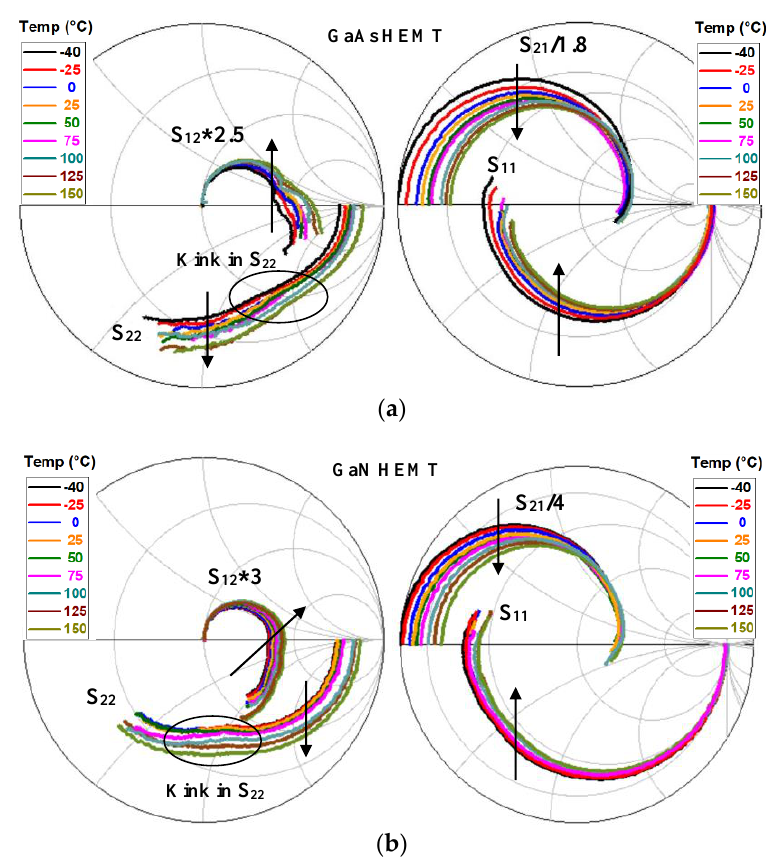
Figure 6. Measured S -parameters of the studied ( a ) GaAs and ( b ) GaN HEMTs at different T a . The illustrated bias points are: V ds = 3 V and V gs = − 0.1 V for the GaAs HEMT and V ds = 9 V and V gs = − 4 V for the GaN HEMT. The frequency range goes from 45 MHz to 50 GHz. (“*” means product (the multiplication operation)).